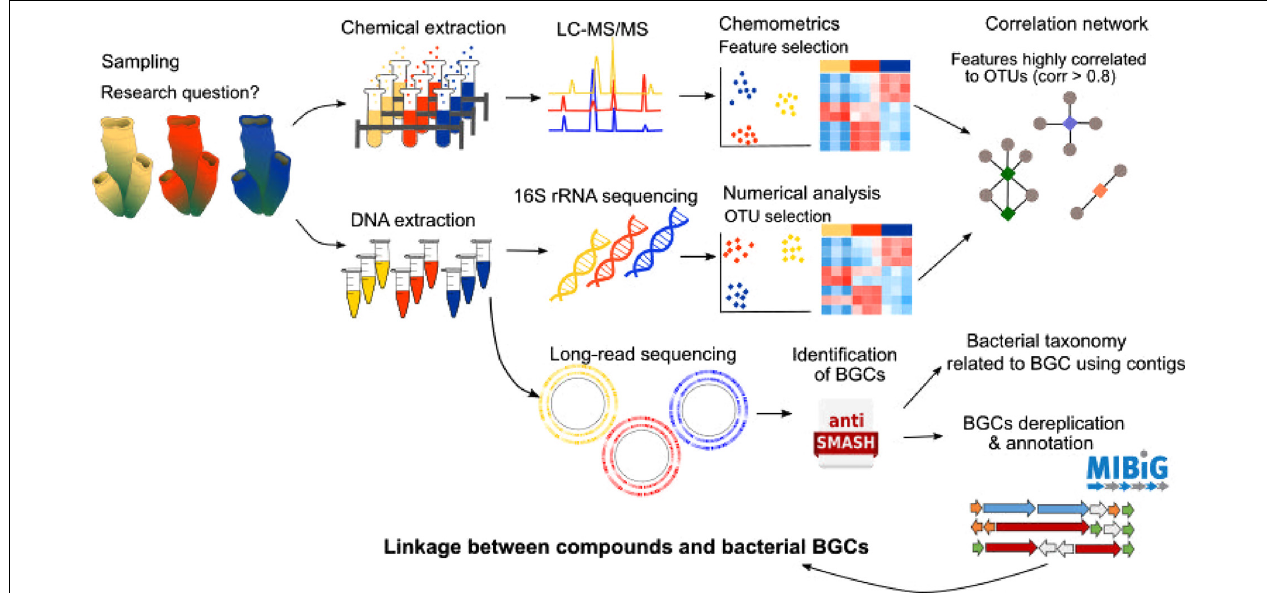
FIGURE 2 | Pipeline illustrating the integration of metabolomics, microbiomics and metagenomics tools. The parallel metabolome and microbiome analysis allows the identification of metabolites of interest that are highly correlated to specific bacterial taxons. Then by performing long-read sequencing and genome mining (using tools such as AntiSMASH or similar) biosynthetic gene clusters (BGCs) can be identified and annotated manually or by using databases such as MIBiG. 16S contigs (i.e., continuous fragments of DNA sequence from an incomplete genome) can then be used to assign the BGCs to specific bacterial taxon genomes. The predicted compounds encoded by these BGCs can then be compared with the metabolome data in order to link produced metabolites with specific bacterial BGCs.